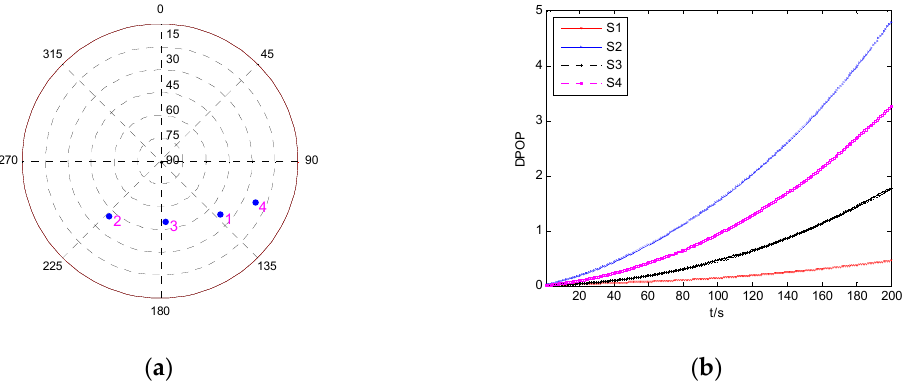
Figure 9. The geometry and DPOP of four visible satellites. ( a ) Sky plot view of the satellite geometry; ( b ) DPOP of each satellite as function of time.